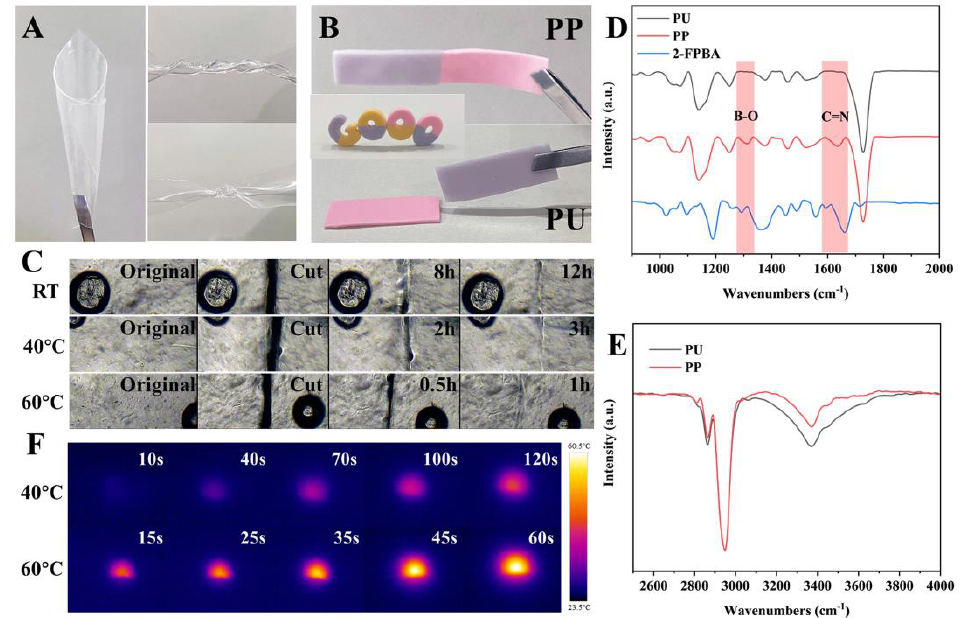
Figure 3. Self-healing properties of PP. ( A ) PP can be bent, twisted and knotted. ( B ) PP can heal itself at room temperature, while PU cannot. ( C ) Optical microscope observation of the self-healing ability of PP at different temperatures. ( D , E ) FT − IR. ( F ) Infrared thermal images of MGPP during warming up.